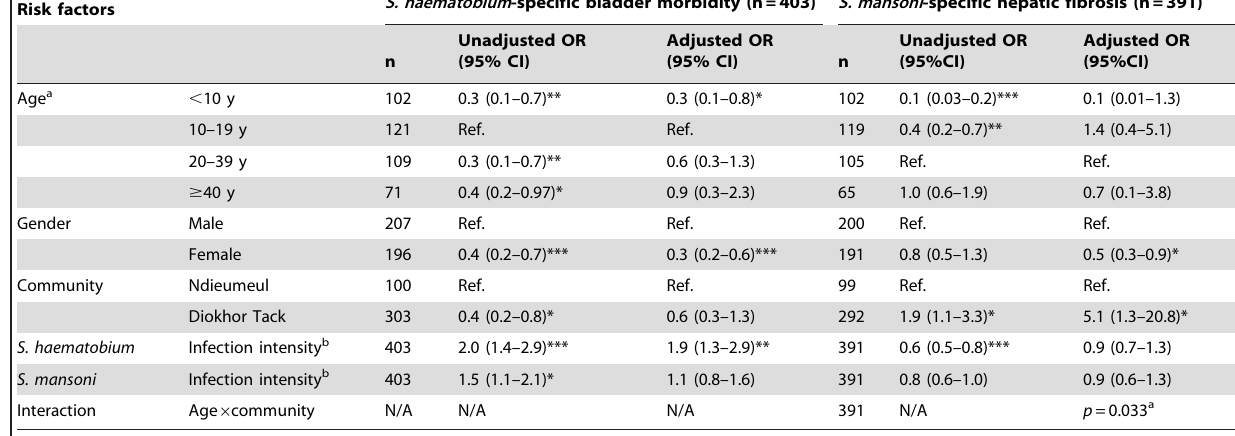
Table 4. Risk factors for schistosomiasis morbidity in the total study population.